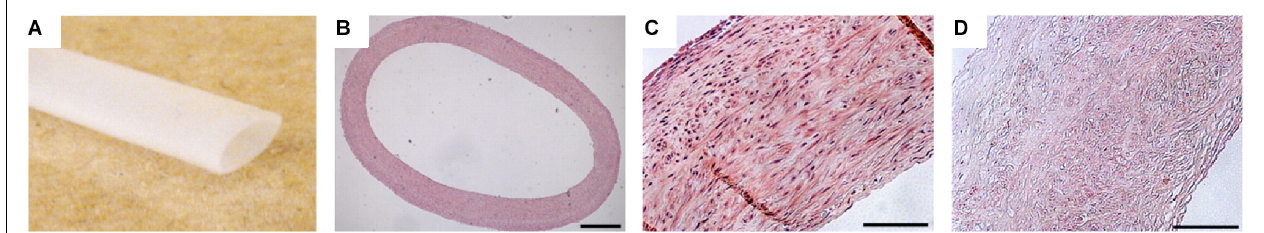
FIGURE 7 | Example of engineered decellularized scaffold for vascular engineering (Quint et al., 2011). Scaffolds were produced by seeding smooth muscle cells onto a poly(glycolic acid) mesh. The scaffolds were cultured until the cells produced a contiguous ECM throughout the mesh and the mesh was almost entirely degraded. At this point, the scaffolds were decellularized, resulting in a cell-derived ECM tubular scaffold. Ultimately, scaffolds were re-seeded with endothelial cells and implanted in a porcine model. (A) Image of decellularized tubular scaffold. (B) Hematoxylin and eosin histological staining of cross-section of scaffold. Hematoxylin and eosin staining of scaffold microstructure (C) before decellularization and (D) after decellularization. Scale bars are 500 µ m. Images were reordered from multiple panels, and lettering has been relabeled for consistency as part of this review article (Quint et al.,